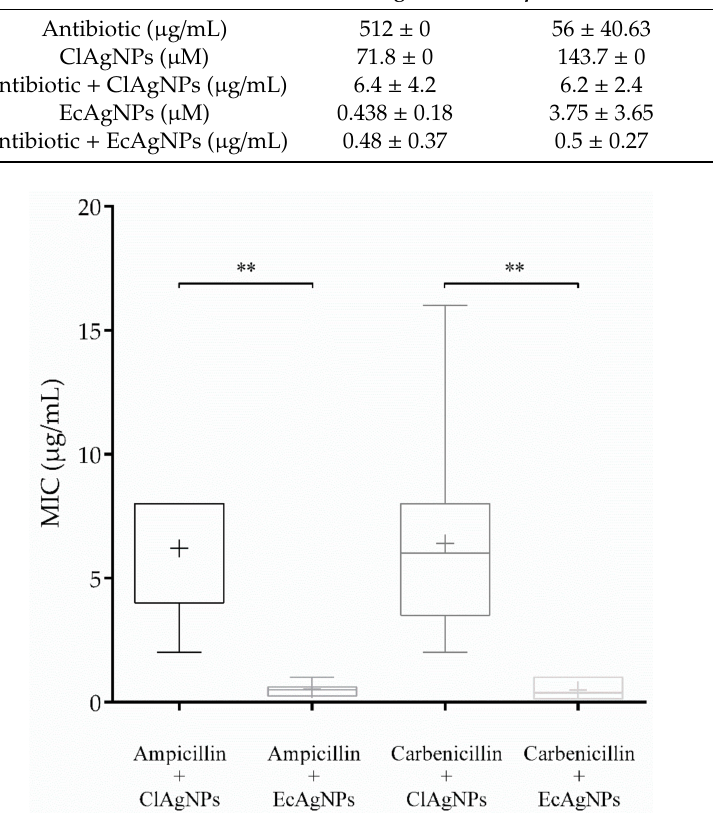
Figure 5. MIC of NPs in combination with ampicillin and carbenicillin (** p value: < 0.01). Statistical di ff erences were found, for S. pseudintermedius, between the combination ampicillin + ClAgNPs and the same antibiotic adjuvated with EcAgNPs ( p -value = 0.002). Similarly, for P. aeruginosa , carbenicillin showed lower MIC when in synergistic combination with EcAgNPs instead of ClAgNPs ( p -value =